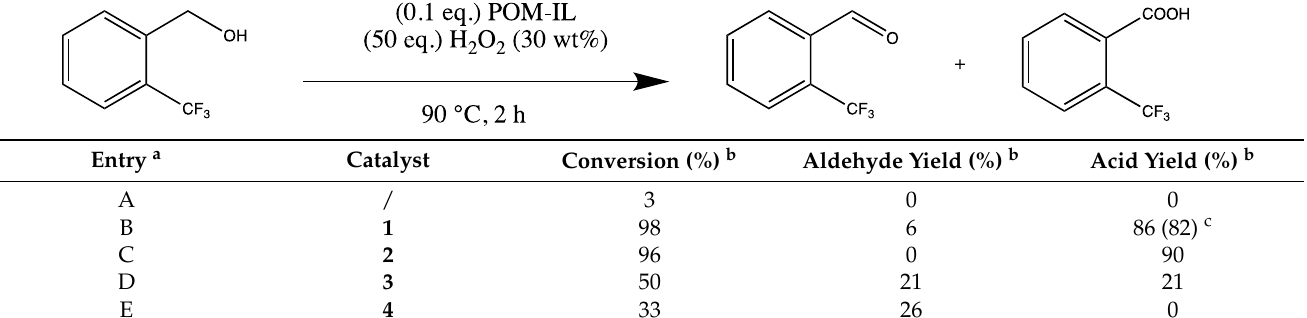
Table 2. Oxidation of 2-trifluorobenzyl alcohol with POM-ILs as solvent and catalyst.